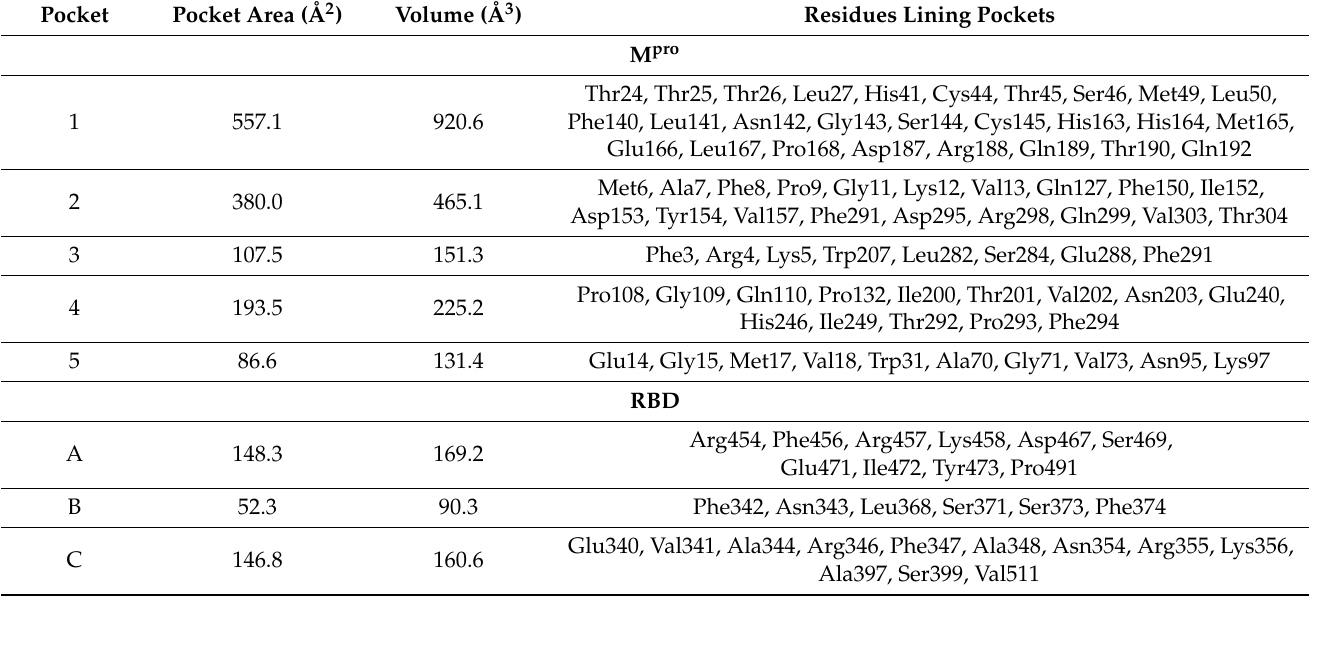
of the SARS-CoV-2 M pro were predicted via CASTp (Table 1) using the M pro structure with a Protein Data Bank (PDB) ID 5R82. Table 1. Predicted binding sites in the viral main protease (M pro ) and receptor-binding domain (RBD) via CASTp, including the dimensions of the volumes and areas.